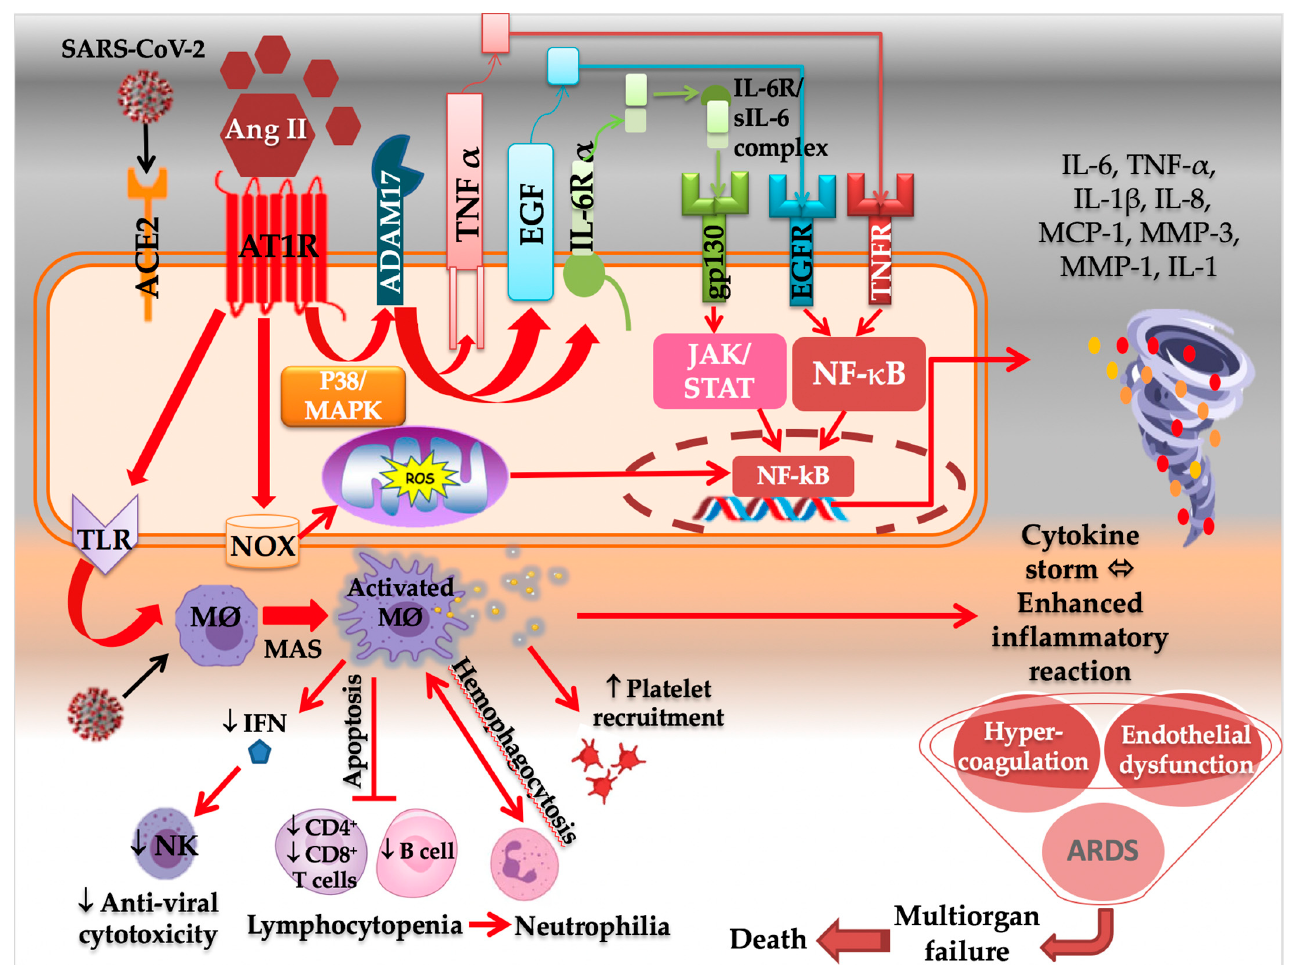
Figure 4. The immunopathological features of SARS-CoV-2 infection. SARS-CoV-2 binding to its cellular receptor (ACE2) favors its subsequent downregulation and the dysregulation of the RAS balance, which will result in a raise in Ang II level. The latter binds to AT1R and activates a series of signaling pathways implicated in the immunopathology process of the virus. Ang II increases ROS production through AT1R-dependent induction of NADPH oxidase (Nox), which will result in mitochondrial dysfunction and DNA damage, and will help the induction of inflammatory cytokines through NF- κ B. ADAM17 is also activated by the Ang II–AT1R axis, via the intracellular p38/MAPK, and will digest the membrane forms of EGF and TNF- α generating their soluble forms, all of which also stimulate the NF- κ B pathway through their specific receptors. The NF- κ B pathway is involved in the pathogenesis of COVID-19, as well as in the induction of cytokine storm by inducing the expression of proinflammatory genes, including IL-6, chemokines, and growth factors. Moreover, ADAM17 cleaves the membrane-bound IL-6R α to the soluble form (sIL-6R α ), which forms a complex with IL-6 and binds to gp130 and will result in the activation of JAK/STAT3 and the induction of excess IL-6. Following the activation of TLRs, macrophages are activated in large amounts, causing secretion. The inflammatory response to SARS-CoV-2 also consists of lymphopenia manifested as a reduction in CD4+ and CD8+ T cells. Such impaired T-cell responses can result from